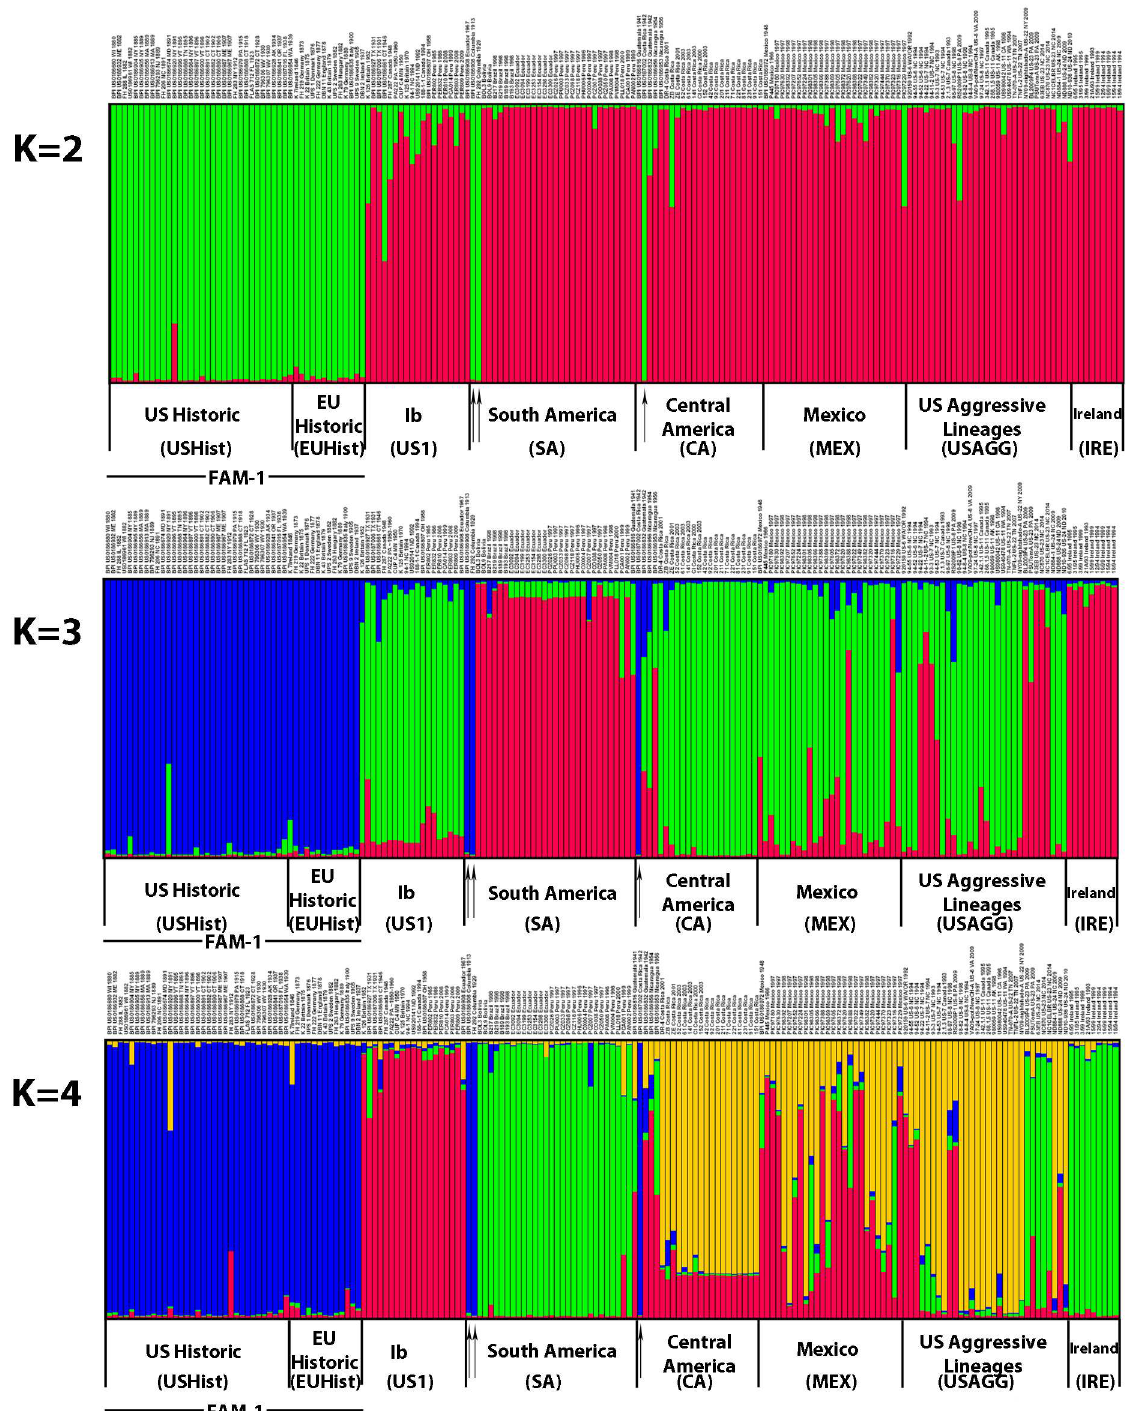
Fig 2. Structure analysis of 12 plex SSR loci from Phytophthora infestans . Optimal value for K was inferred to be K = 2 based on analysisby Structure Harvester and K = 4 basedon evaluationof probabilities [43]. The oldest SSR lineage, FAM-1 consisted of samples from US (1855–1958) and EU Historic (1846–1970) outbreaks. Black arrows indicate specimens from the oldest South and Central Americanoutbreaksthat were also identifiedas FAM-1 lineages.A completelist of samples is shown in the S1